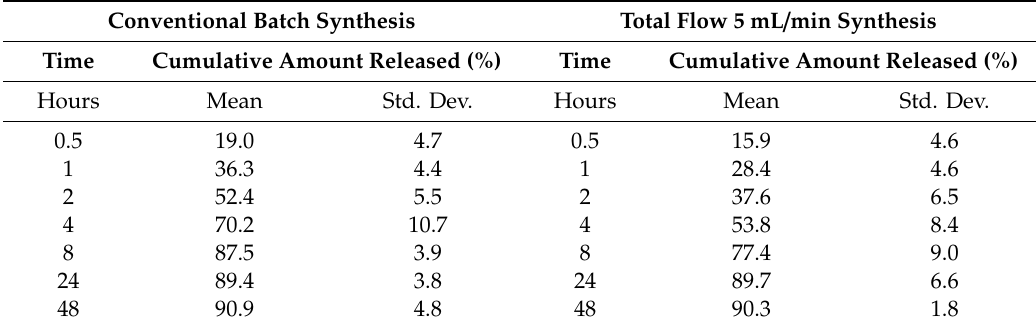
nanoprecipitation method and by micromixer-assisted